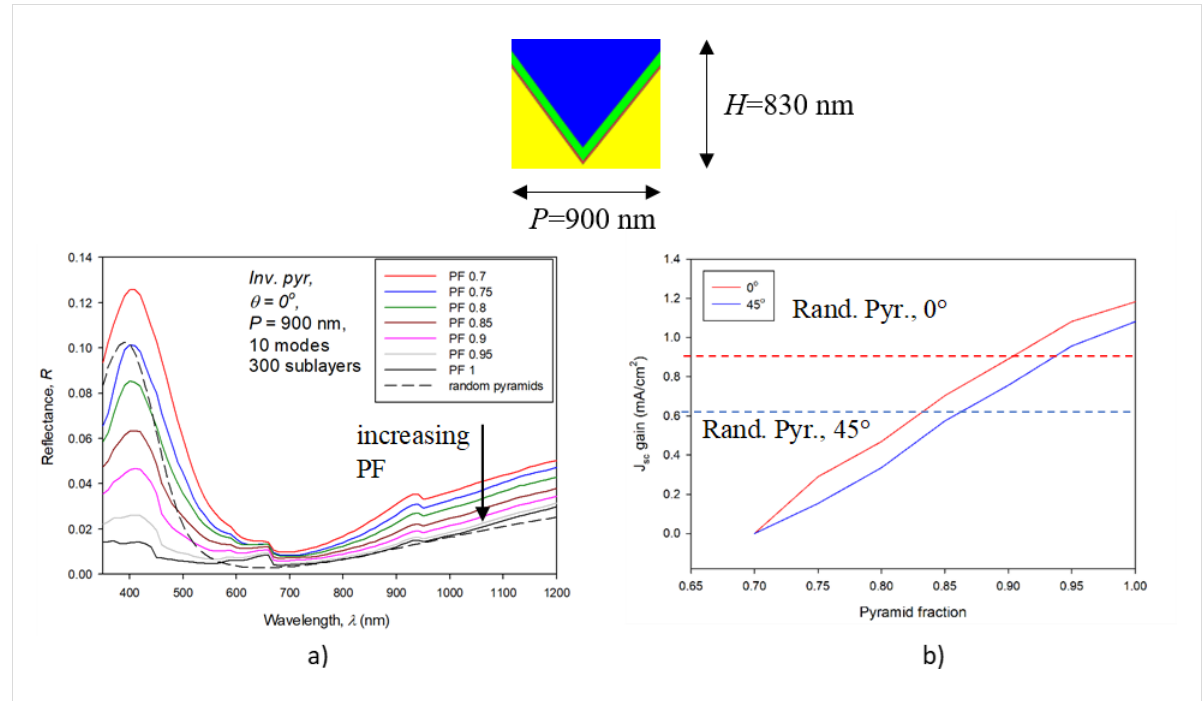
Figure 7: The effect of increasing the pyramid fraction (PF) in the texture in the front part of the solar cell. Reflectance as a function of wavelength for normal incident light (a) and the resulting J SC gain for the two incident angles (b).